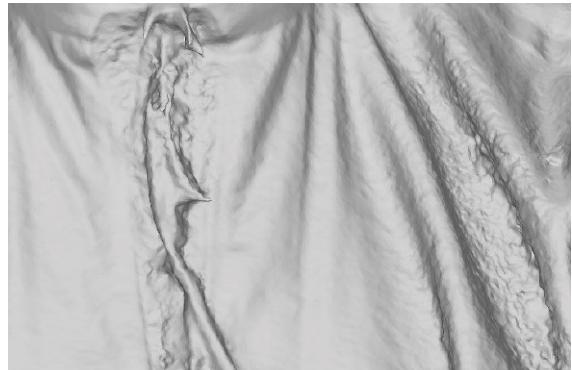
Figure 5. Detail of costume 3D model where details (laces, cloth folds) proved to be problematic due to lack of spatial separation and difficult accessibility.